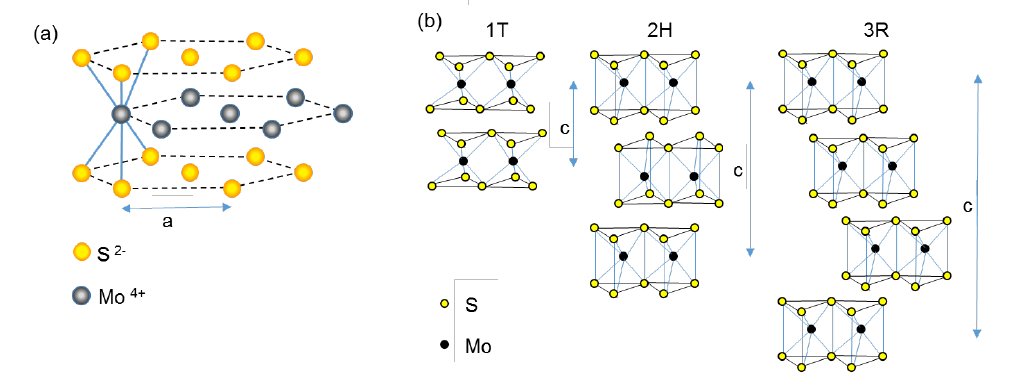
Figure 2. ( a ) Hexagonal structure of S and Mo layers; ( b ) Side view schematic illustration